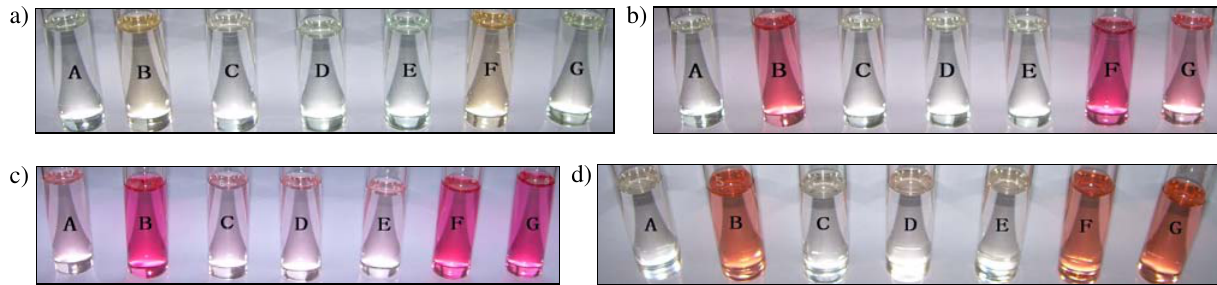
Fig. 3. Color changes of four compounds (4.0 × 10 –5 mol·L –1 ) in DMSO in absence and presence of different anions. a) 1 ; b) 2 ; c) 3 ; d) 4 . (A: only compound; B: compound + 10 equiv. F – ; C: compound + 10 equiv. Cl – ; D: compound + 10 equiv. Br – ; E: compound + 10 equiv. I – ; F: compound + 10 equiv. AcO – ; G: compound + 10 equiv. H PO 4– ). 2